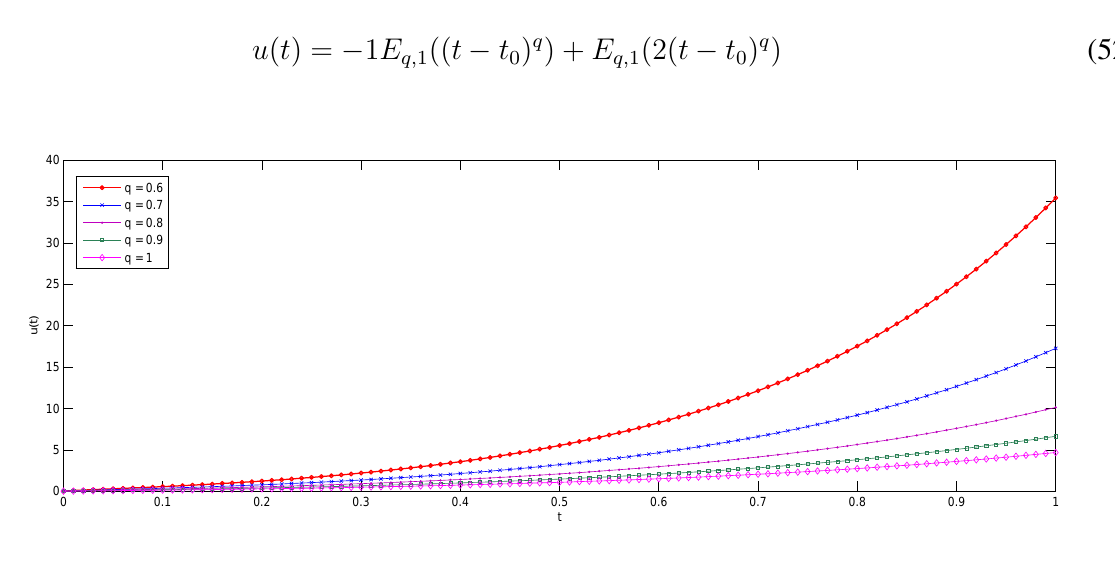
Figure 3. Graph for real and distinct roots when q = 0 . 6 , 0 . 7 , 0 . 8 , 0 . 9 , 1 . 0 .